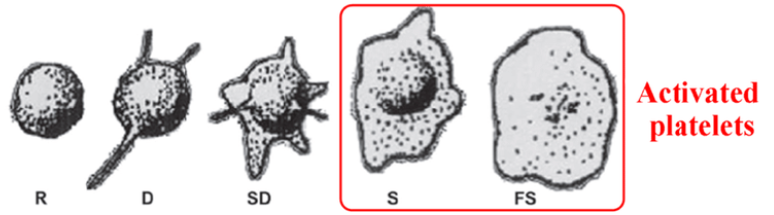
Figure 5. Platelet’s morphology after the adhesion. Their shape is marked as: round (R), dendritic (D), spreading dendritic (SD), spreading (S), and fully spread (FS). Reprinted with permission from Ref. [68] copyright 2014 American Chemical